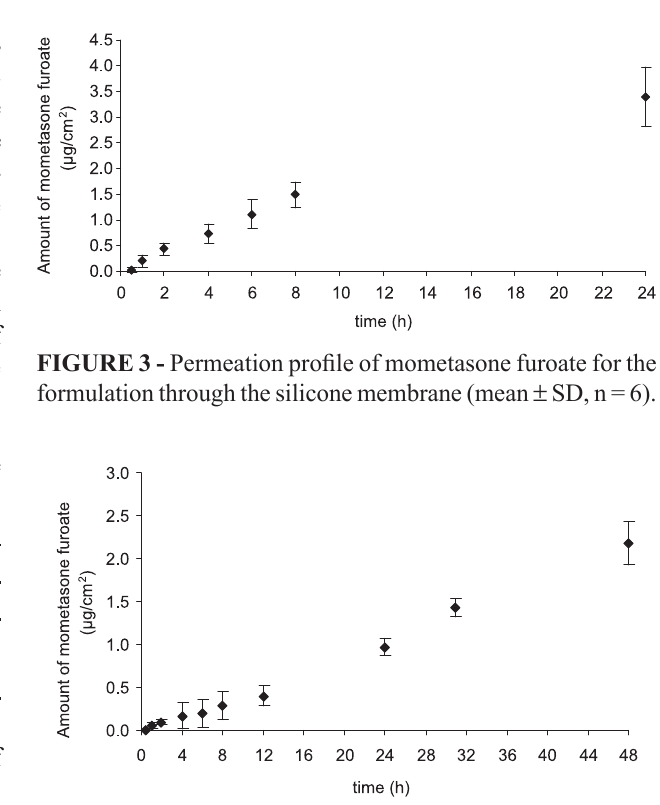
FIGURE 4 - Permeation profile of mometasone furoate for the formulation through the skin membrane (mean ± SD, n =